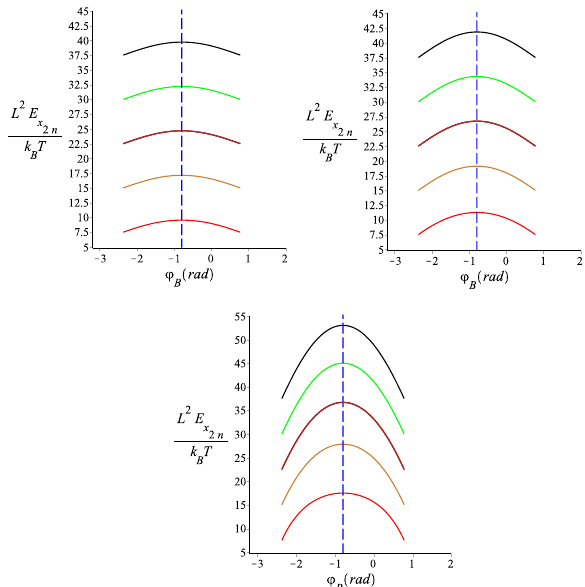
Figure 14. The dimensionless tensile stiffness of the structure with an even number of arms as a function of the orientation of the external magnetic field. The red, gold, brown, green, and black = 10,20,30,40,50, are associated with fixed values of the single-arm bending stiffness parameter l p L respectively. The other fixed parameters are: ω = π , φ µ = 0, and n = 2. For the top left panel, we 4 have K B = 0.5. For the top right panel, we have K B = 1. For the lower panel, we have K B =